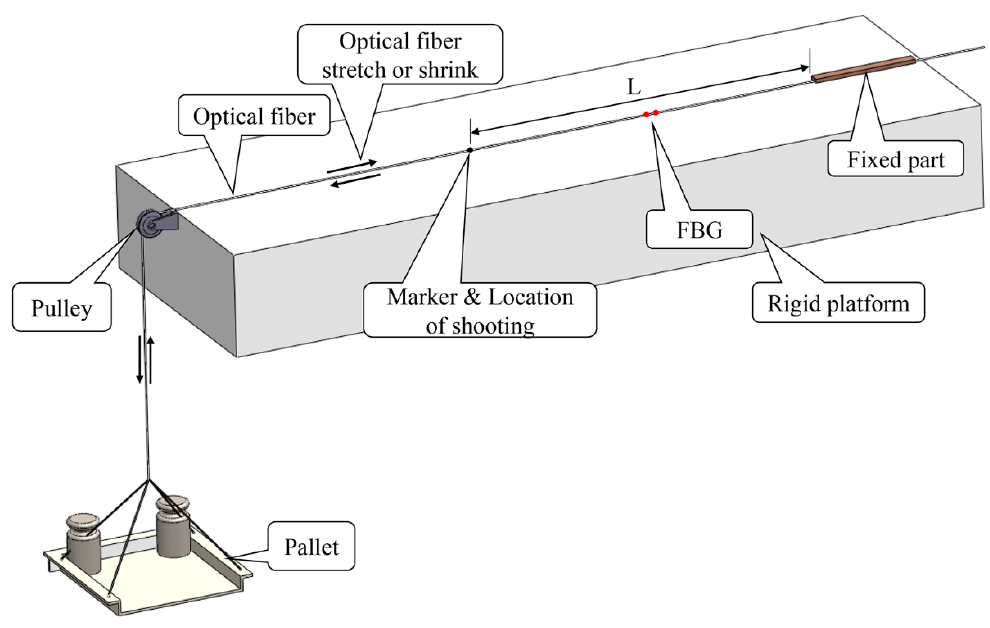
Figure 3. Partial diagram of the test.